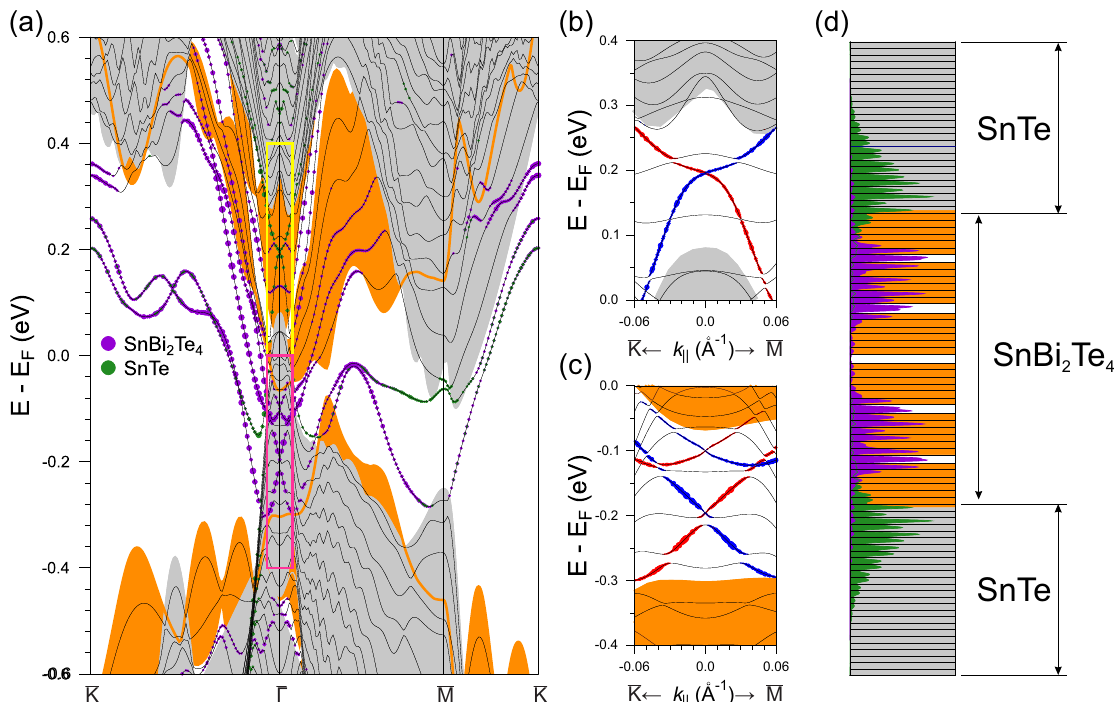
Figure 3. Electronic structure of the abrupt SnBi 2 Te 4 /SnTe interface ( a ). Orange (grey) background corresponds to SnBi 2 Te 4 (SnTe) projected bulk band structure. The radii of the color circles reflect the localization of the states in the near-interface layers. Magnified view of the ¯ Γ Dirac states of SnTe (yellow rectangle in ( a )) ( b ) and SnBi 2 Te 4 (magenta rectangle in the panel ( a )) ( c ), where size of red and blue circles reflects values of the positive and negative in-plane components of the spin eigenvalues, respectively ( b , c ). The charge density ρ (z) of the SnBi 2 Te 4 (SnTe) Dirac states integrated over the xy plane ( d